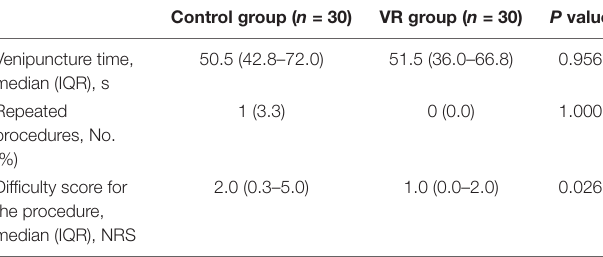
TABLE 3 | Venipuncture time, the requirement of needle re-insertion, and difficulty score during the